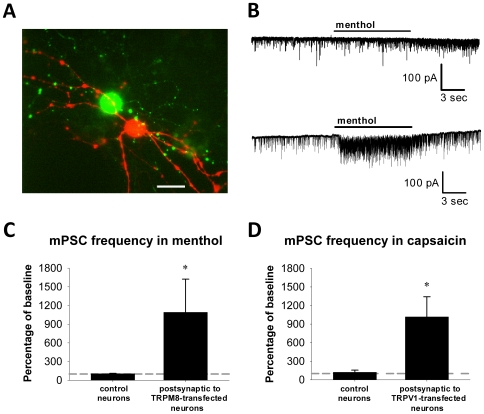
Agonist treatment in 0.5 µM tetrodotoxin (TTX) increases presynaptic transmitter release in transfected neurons.(A) Fluorescence image of a TRPM8-transfected neuron (green) forming presumed presynaptic contacts onto a postsynaptically-recorded cell (red) filled with Alexa Fluor 568, which was included in the recording pipette. Scale bar denotes 50 µM. (B) Example of miniature excitatory postsynaptic currents (mEPSCs) recorded from non-transfected postsynaptic partners of TRPM8-transfected neurons (bottom panel) or from non-transfected neurons not in contact with transfected neurons (top panel) in 0.5 µM TTX. During 100 µM menthol application, mEPSC and mIPSC frequency increased in neurons postsynaptic to TRPM8-transfected neurons but not in control neurons. (C) Quantification of the mPSC frequency during 100 µM menthol application compared to the baseline frequency (dashed line). Error bars represent SEM. In neurons postsynaptic to TRPM8-transfected neurons, but not in control neurons, the mPSC frequency increased significantly in menthol (Fisher's exact test, p<0.005). (D) Quantification of the mPSC frequency during 500 nM capsaicin application compared to baseline frequency (dashed line) in neurons postsynaptic to TRPV1-transfected neurons or to control neurons. Error bars represent SEM. In neurons postsynaptic to TRPV1-transfected neurons, but not to non-transfected neurons, the mPSC frequency in capsaicin increased significantly (Fisher's exact test, p<0.01).